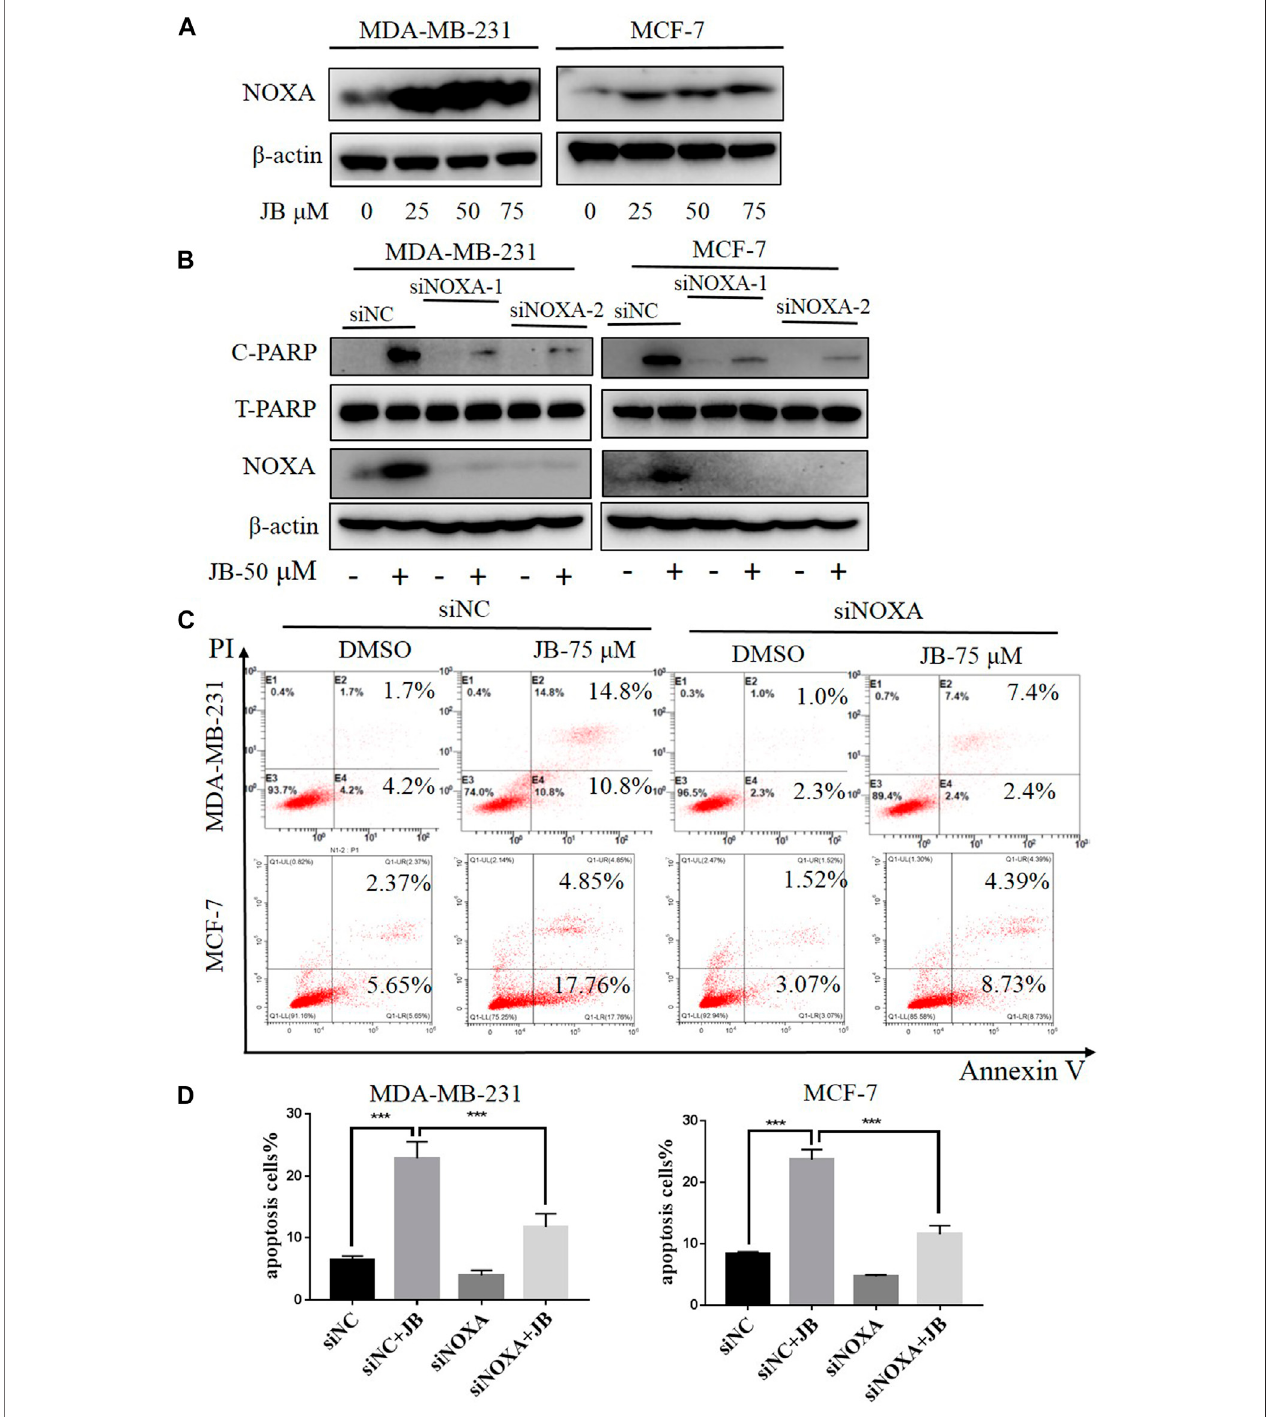
FIGURE 3 | JB-induced apoptosis was mediated by NOXA. Cells were treated with DMSO or indicated concentrations of JB for 48 h and harvested for cell lysis preparation. The expression level ofNOXA wasdetected bywestern blot (A) .Transfection ofsiRNA wasconductedtoknock down the expression ofNOXA followed by treatment of JB for 48 h. The expression of NOXA, C-PARP, and T-PARP was detected by western blot (B) . Flow cytometry was performed to detect apoptosis (C) . Statistical analysis of the relative apoptotic percentages were presented by mean ± SEM (D) . * p < 0.05; ** p < 0.01; *** p < 0.001, n (cid:2) 3.